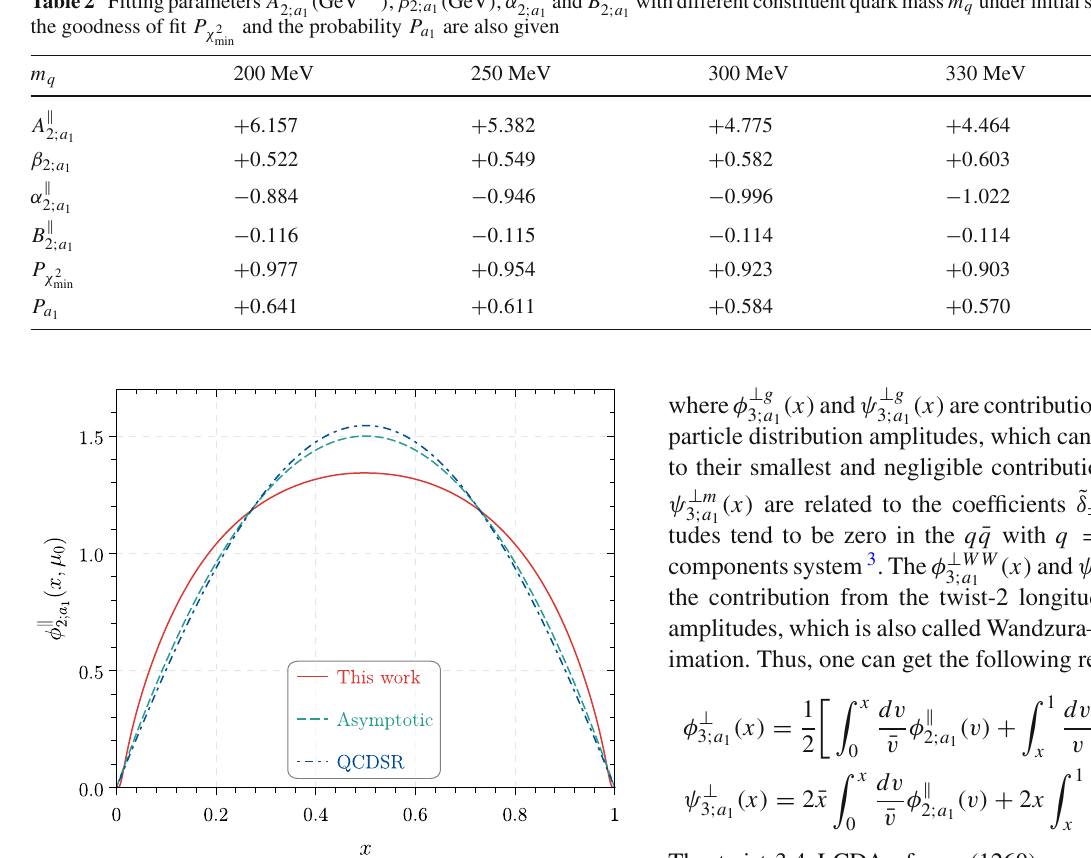
(cid:3) ( x ,μ ) . 0 2 ; a 1